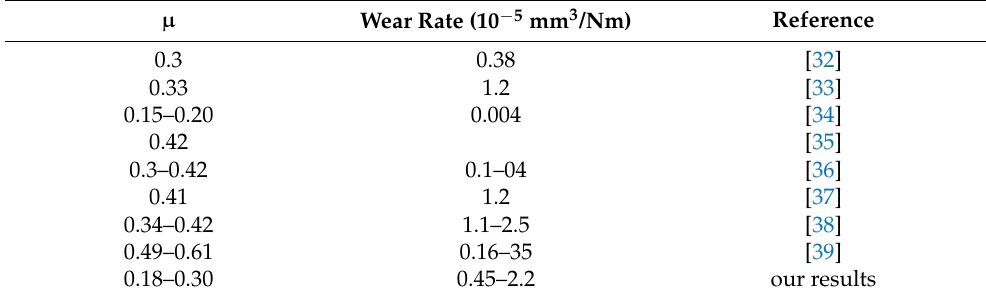
Figure 1. The coefficient of friction under constant load as functions of radiation dose of PEEK. Table 2. Friction coefficient value of